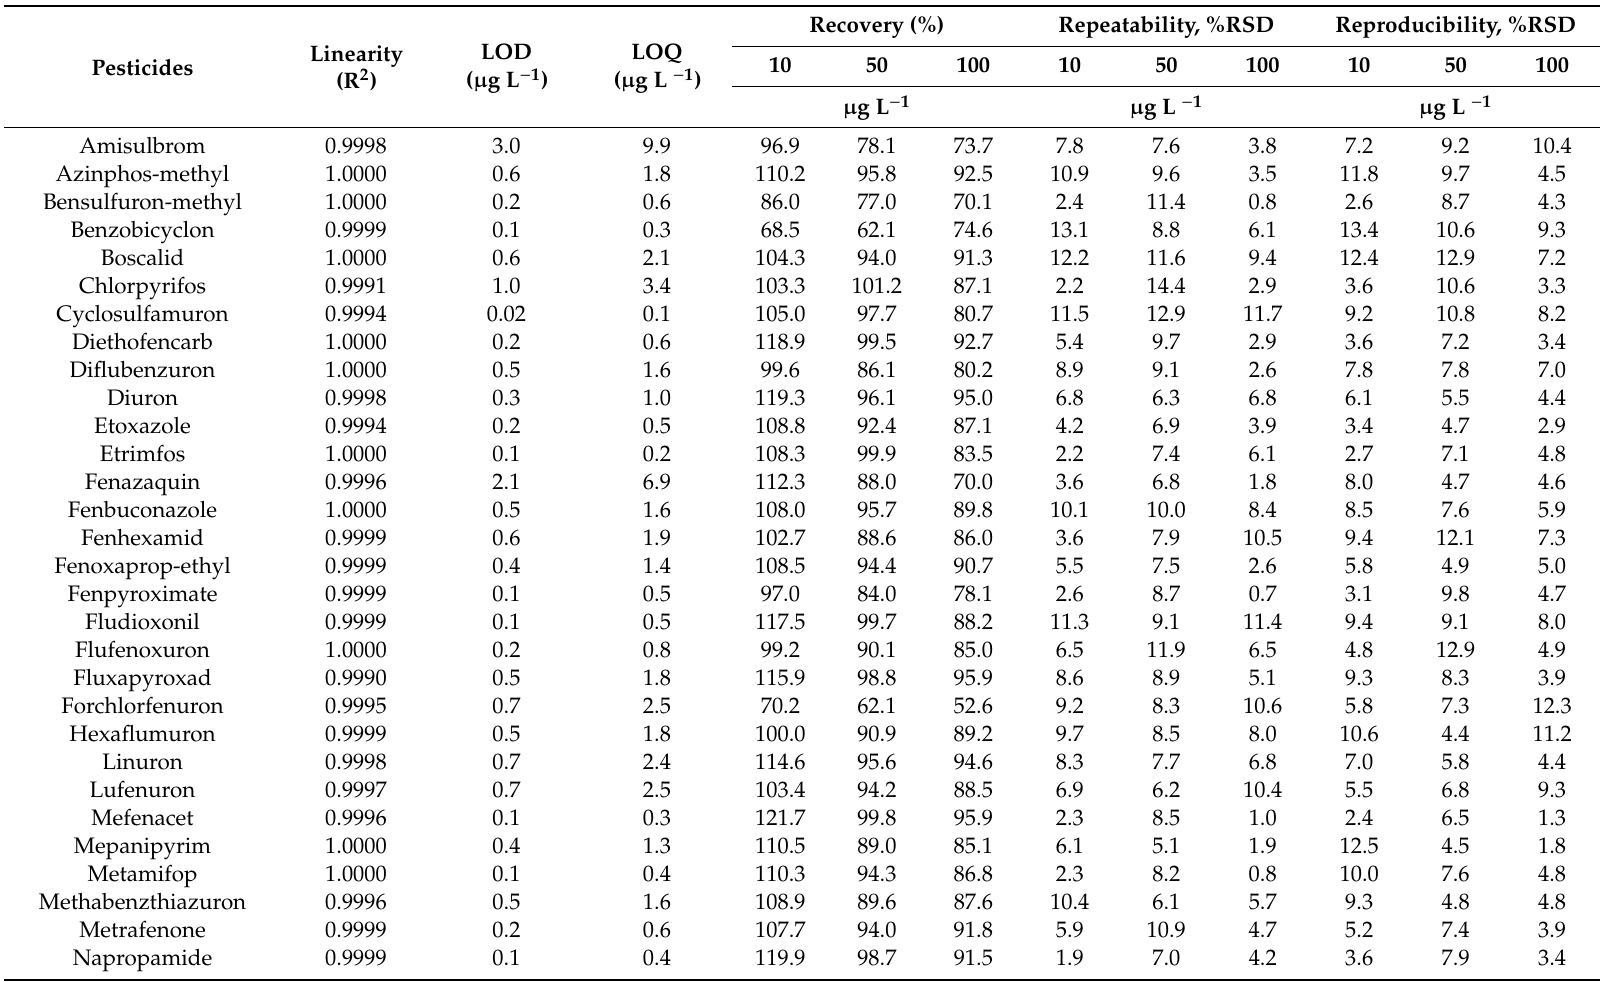
Table 2. Method validation data of selected 55 pesticides in water using Clean-up V (7.5 mg ENVI-Carb, 25 mg PSA, and 150 mg MgSO 4 ) with LC-MS / MS. Range of pesticides concentration between 0.1 to 100 ( µ g L − 1